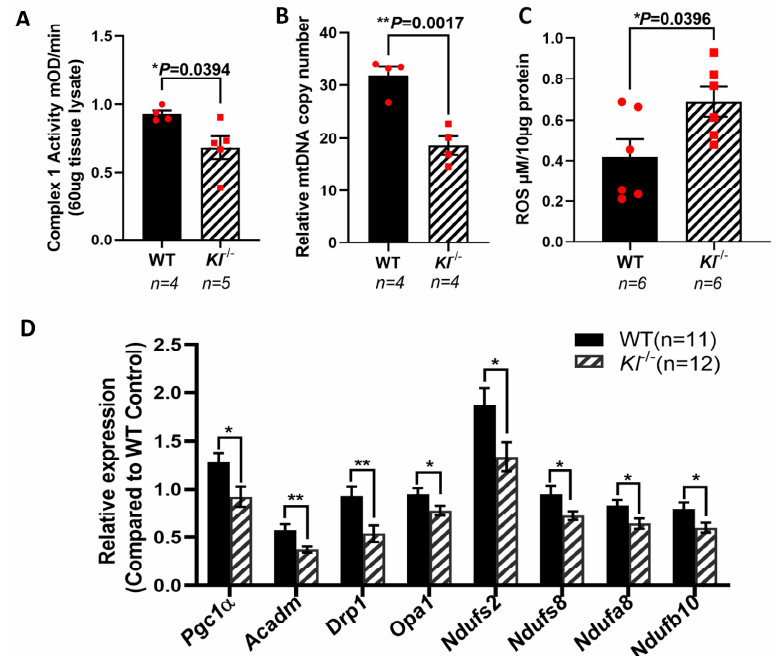
Figure 5. Reduced mitochondrial activity and elevated ROS in the RPE/retina of Kl -/- mice. ( A ) Respiratory chain complex I activity is reduced in the RPE/retina of Kl -/- mice, as compared to that of the control. ( B ) The mtDNA copy number was measured in the RPE/retina of Kl -/- and WT mice (n = 4) by qPCR, showing significantly reduced mtDNA in the RPE/retina of Kl -/- as compared to WT mice. ( C ) ROS production was significantly higher in the RPE/retina of Kl -/- mice. ( D ) The expression of mitochondrial activity-associated genes Pgc-1 α , Acadm , Drp1 , Opa1 , Ndufs2 , Ndufs8 , Ndufa8 , and Ndufb10 was decreased in the RPE/Retina of Kl -/- mice as compared to WT mice. Graph represents mean ± SEM (WT group n = 11, 5 male and 6 female mice; Kl -/- group n = 12, 6 male and 6 female mice). The unpaired t -test was performed using GraphPad Prism 8.3.0. * p ≤ 0.05, ** p ≤ 0.01.